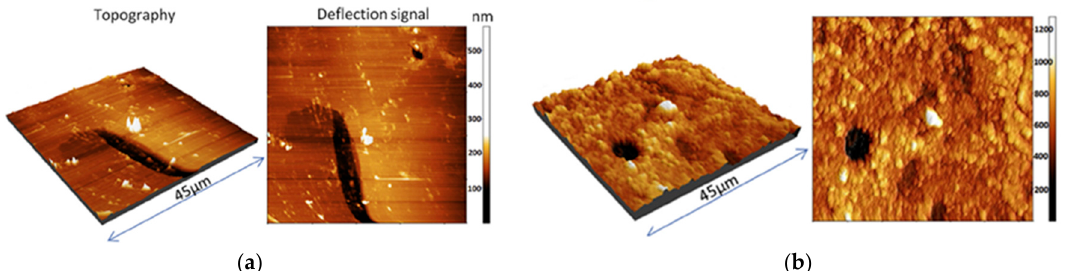
Figure 11. Atomic force microscopy (AFM) images of the measured calcite surface: ( a ) before; ( b ) after nano-modification [28].